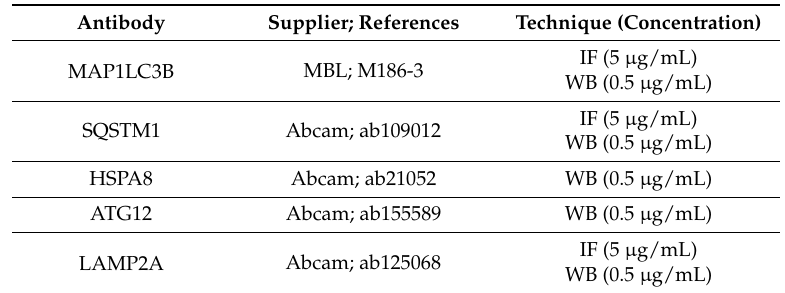
Table 2. References of antibodies used in our settings to analyze autophagy activity by IF and WB in sciatic nerves from Lewis